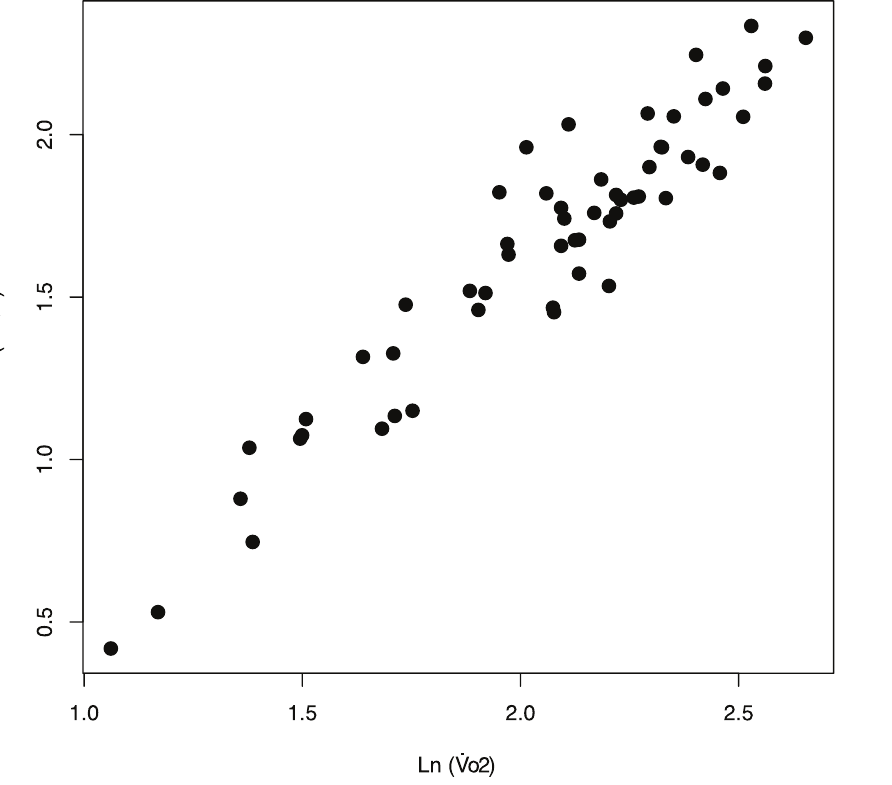
Figure 3. Relationship between Ln ( _ VV O 2 : oxygen consumption rate) and Ln ( _ VV C O 2 : carbon dioxide production rate) in incubating ancient murrlets at Reef Island in 2010 ( N =18 birds, N =58 measurements).